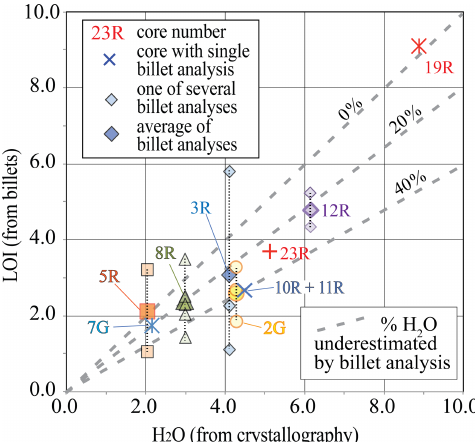
Figure 12. The comparison of the values of weight loss on ignition (LOI) from channel samples of the bulk cores from Hole J (this study) with values analyzed aboard the JR from billets cut from the same cores. The values of LOI from billets are as much as 40% smaller than found in the bulk core samples.